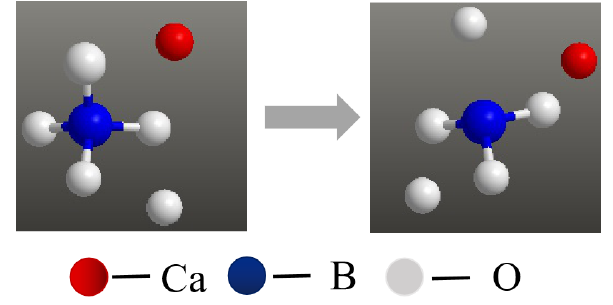
crease in the content of [BO ] structure in the slag. In addi- 3 tion, the absorption peaks in the range of 800-1200 cm −1 also show an increasing trend with the increase of the ra- tio of (B O /SiO ), which indicates that the increase of 2 3 2 (B O /SiO ) will promote the formation of Si-O-B. 2 3 2